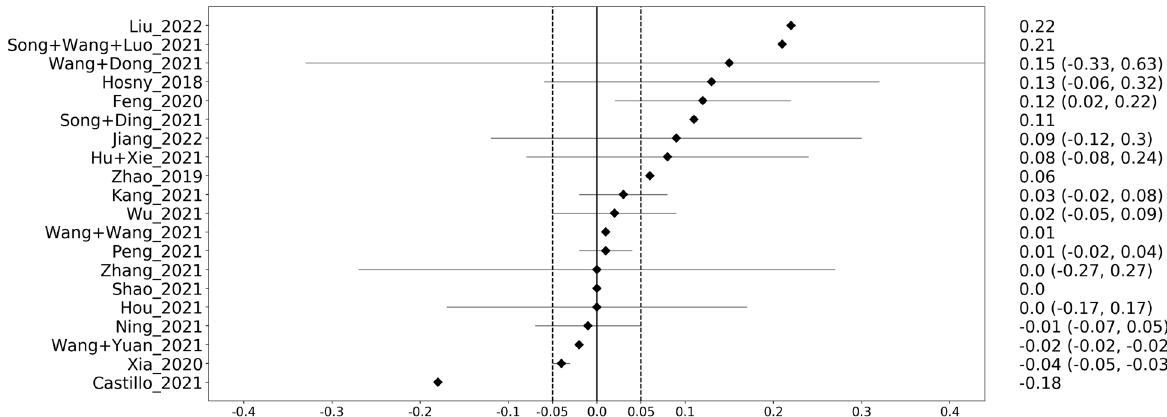
Fig. 5 Graphical display of the performance differences between the generic and deep models on the external validation sets. On the right, the difference in area under the curve together with the 95% confidence interval is given. A positive difference means that the deep model performed better than the generic model